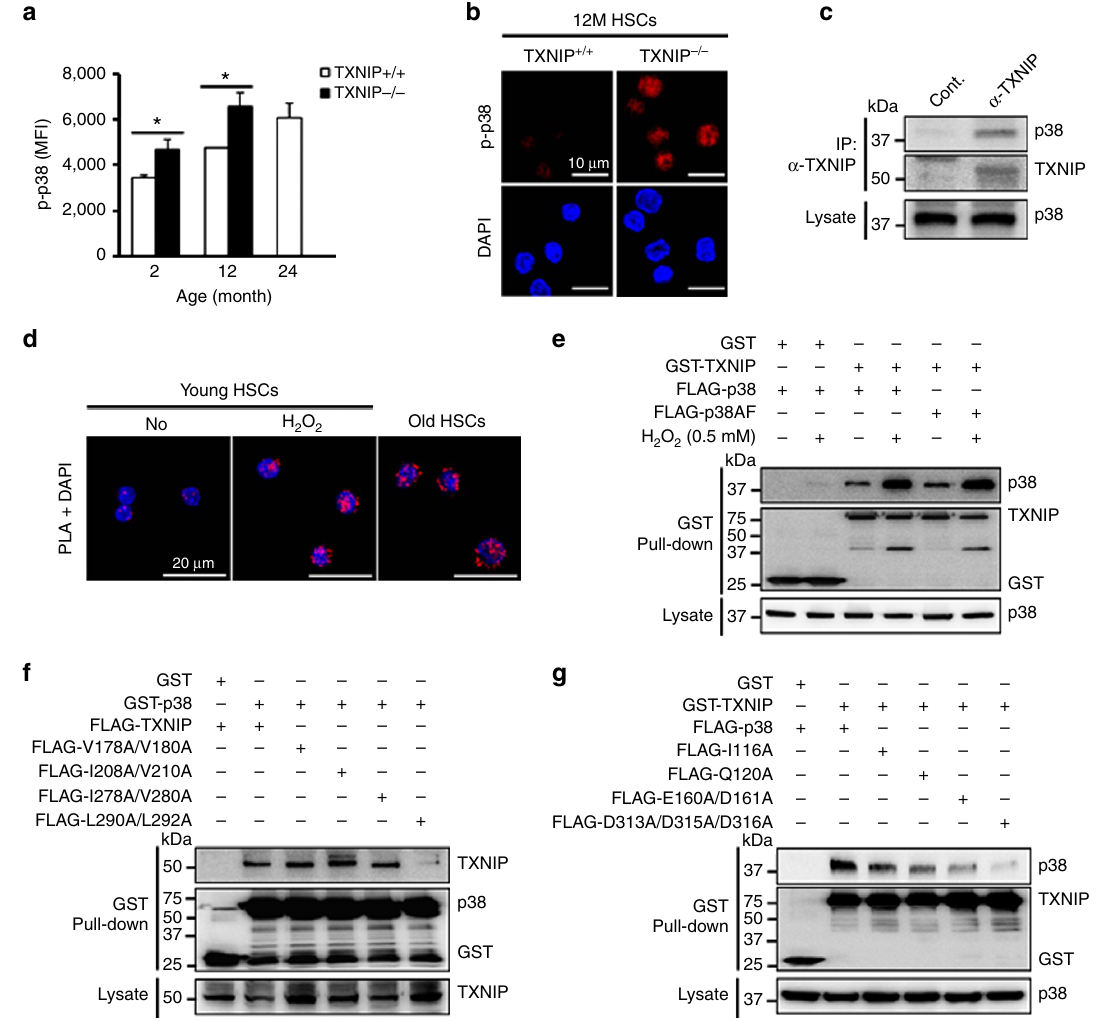
Figure 2 | The activation of p38 in TXNIP (cid:2) / (cid:2) HSCs and physical interaction between TXNIP and p38 in HSCs. ( a ) Levels of p38 phosphorylation were determined by mean of fluorescence intensity using flow cytometry in LT-HSCs ( n ¼ 3 from two experiments). ( b ) Confocal images of phospho-p38 in 12-month-old LT-HSCs ( n ¼ 3 from two experiments). ( c ) Immunoprecipitation assay in young BM cells (repeated two times). ( d ) In situ PLA images in young LT-HSCs or old HSCs. Freshly isolated LT-HSCs were treated with 0.5mM H 2 O 2 for 1h in HSC media (repeated two times). ( e ) GSTpull-down assay in 293T cells (repeated two times). ( f , g ) GST pull-down assays in 293T cells (repeated three times). Data are mean ± s.d. Statistical significance was determined using a two-tailed Student’s t -tests. * P o